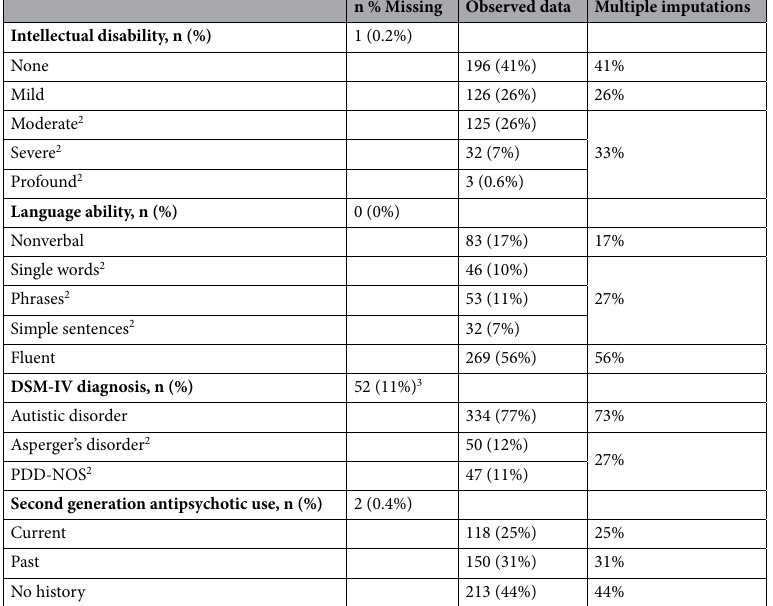
Table 2. Clinical characteristics of ASD patients with electronic health record data from the past 5 years, based on observed data (n = 483) and multiple imputations 1 . ASD autism spectrum disorder, DSM-IV Diagnostic and Statistical Manual of Mental Disorders, Fourth Edition, PDD-NOS pervasive developmental disorder-not otherwise specified. 1 One thousand imputations were generated using chained equations with sex, age (linear and squared terms), intellectual disability, language ability, DSM-IV diagnosis of autistic disorder, second generation antipsychotic use, hypertension, and most recent body mass index (BMI) measurement from the past 5 years as covariates. 2 Categories were combined prior to multiple